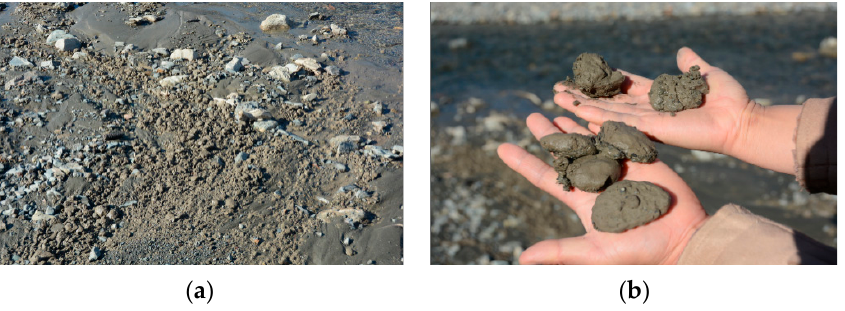
Figure 2. Sediment discharged from the test pipeline at the dredging site. ( a ) Sediment discharged from the pipeline, ( b ) Pebbles discharged from the pipeline.